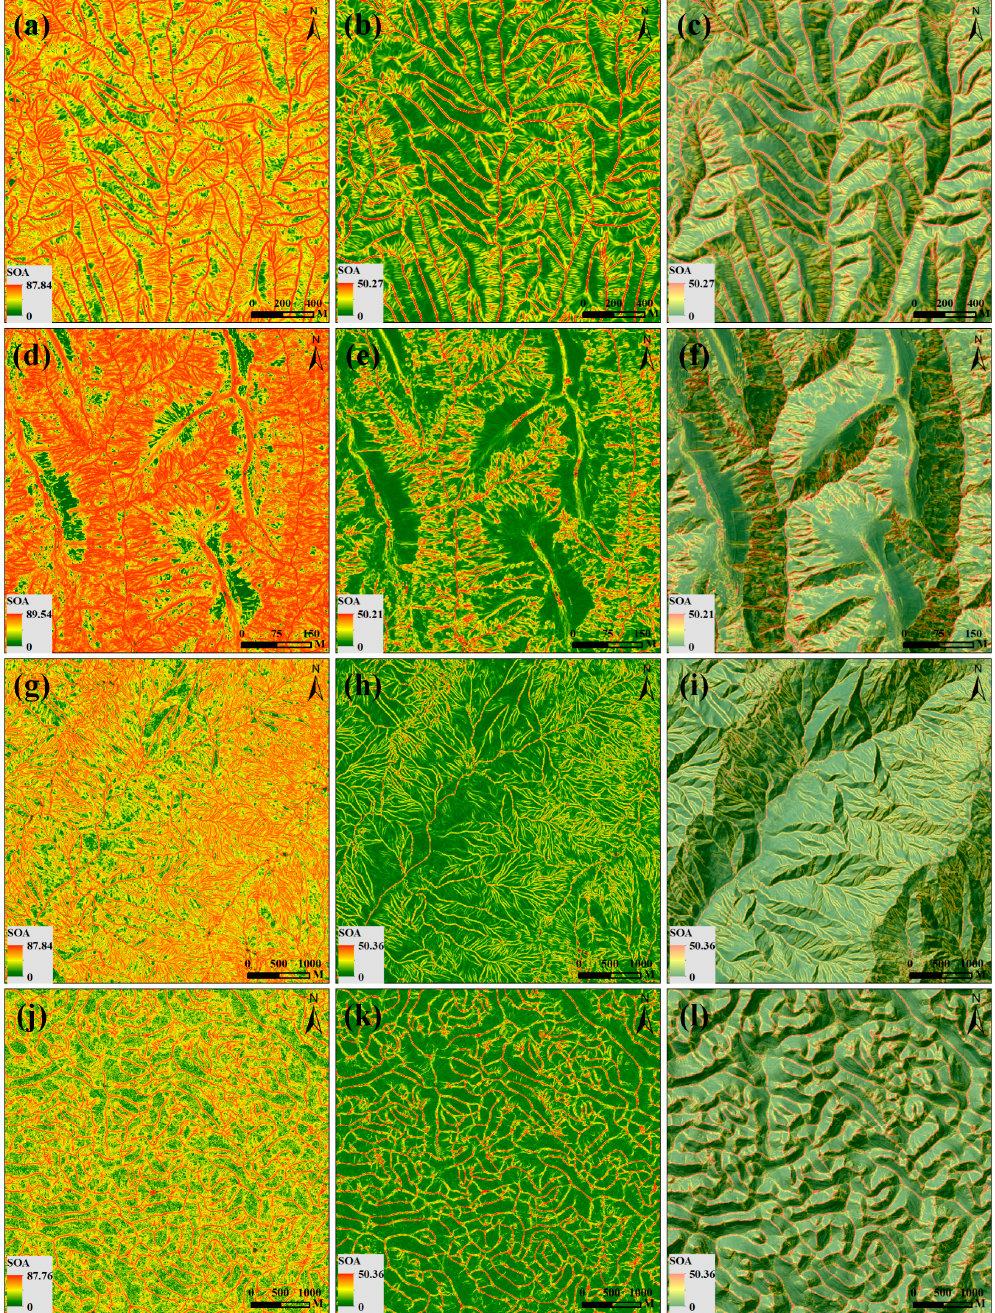
7 Figure 7. SoA results of di ff erent methods in di ff erent areas. ( a ) P–N and ( b ) vector methods in Suide TA1, ( c ) vector method with hill shading in Suide TA1, ( d ) P–N and ( e ) vector methods in Suide TA2, ( f ) vector method with hill shading in Suide TA2, ( g ) P–N and ( h ) vector methods in Mount Lu, ( i ) vector method with hill shading in Mount Lu, ( j ) P–N and ( k ) vector methods in Dahua, ( l ) vector method with hill shading in Dahua. The unit is